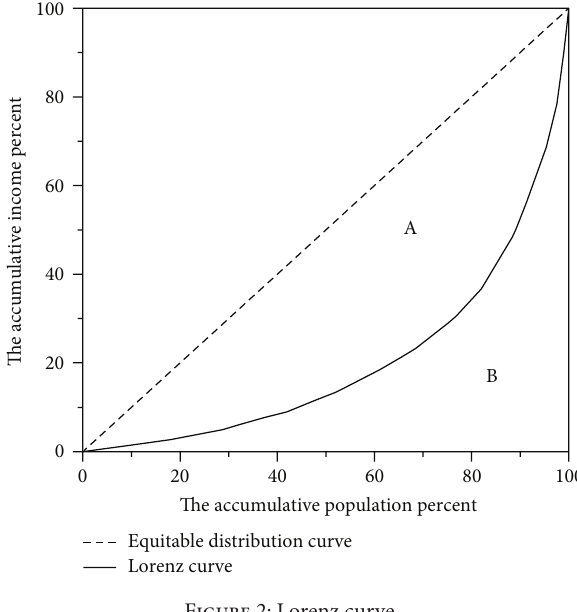
Figure 2: Lorenz curve.